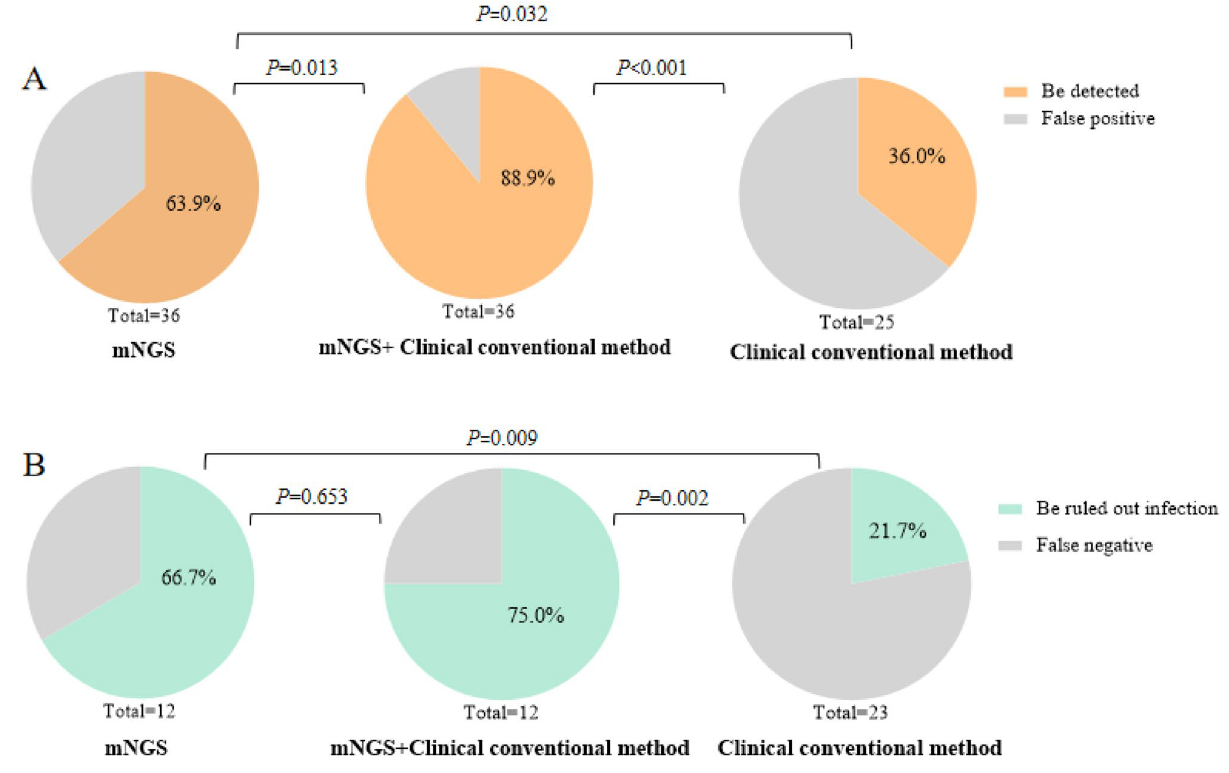
Figure 4. The sensitivity and specificity of mNGS and clinical conventional testing in diagnosis of CNS disorders in PLWHA. ( A ) Comparison of sensitivity; ( B ) Comparison of specificity.